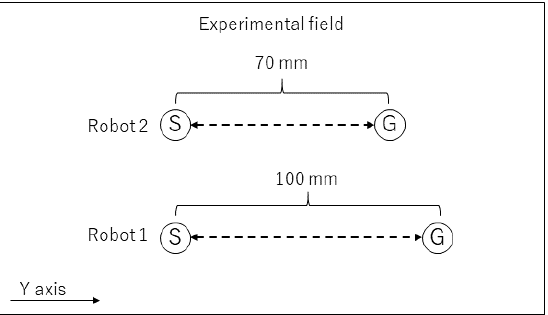
Figure 8. Simplified overview of the actual learning environment. This figure is a bird’s-eye view. S denotes the start position and G denotes the goal